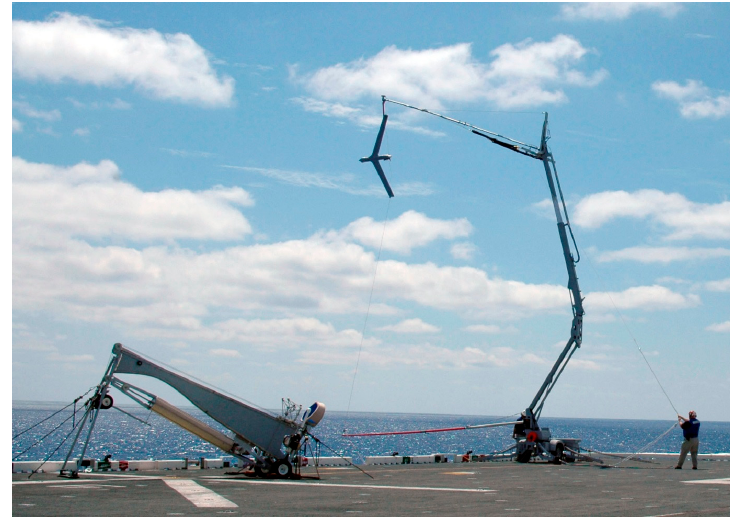
Figure 1. ScanEagle ® unmanned aerial vehicle (UAV) (Boeing Insitu, Bingen, WA, USA) lands on skyhook for recovery. The SuperWedge ® pneumatic launching catapult (left) can be mounted on vessels. © United States Navy.